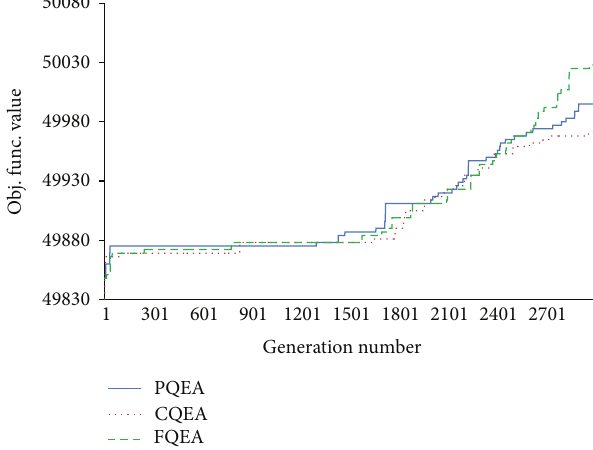
Figure 30: Convergence graph of PQEA, CQEA, and FQEA on 0- 1 knapsack problem profit ceiling data instances with number of items, 𝑀 , being 5000 and capacity, 𝐶 , being 5% of total weight.